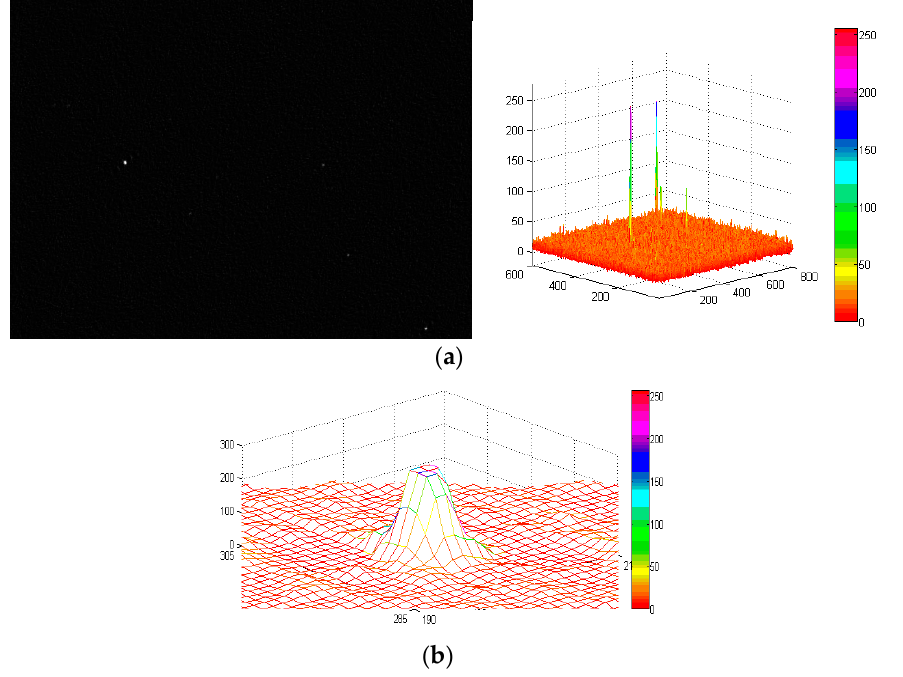
4 / w w s = = ° 4 / w w s = = ° . ( a ) Star x y . ( a ) Star x y